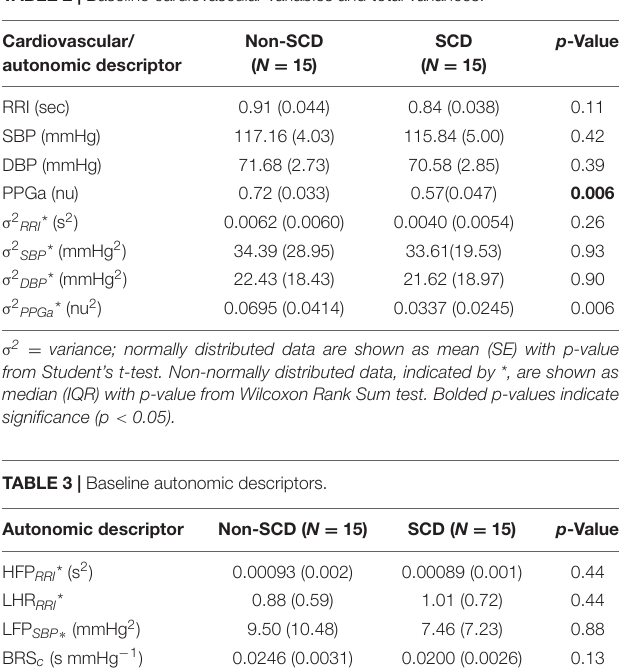
TABLE 2 | Baseline cardiovascular variables and total variances.